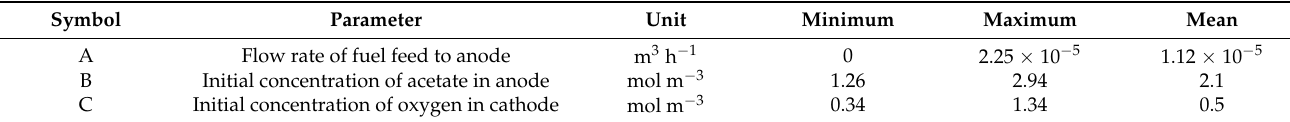
Table 2. Values of independent variables used for the process